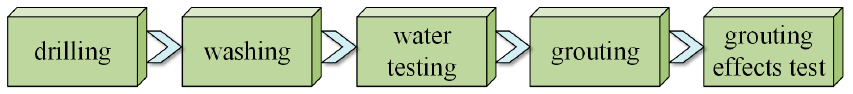
Figure 1. The representation of grouting procedures.